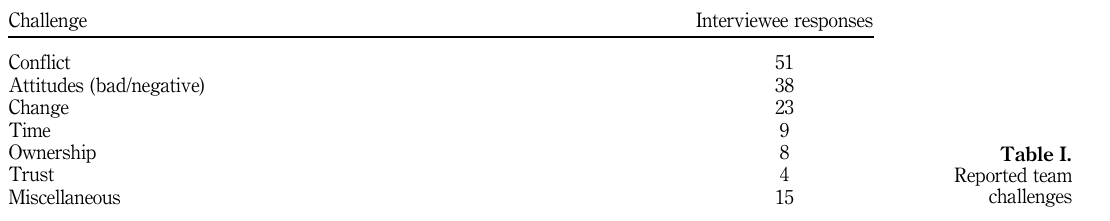
Table I. Reported